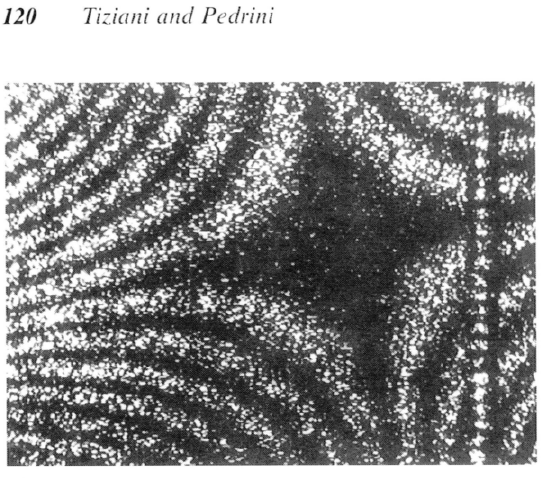
corded speckle images is necessary. The images are then substracted one from the other and the absolute value is taken and stored in the frame grabber. Figure 5 shows the result for a vibrating plate after the subtraction between the two speckle pattern. The pulse separation was 100 f-.Ls. It was even possible to record two separated images using pulse separation of 5